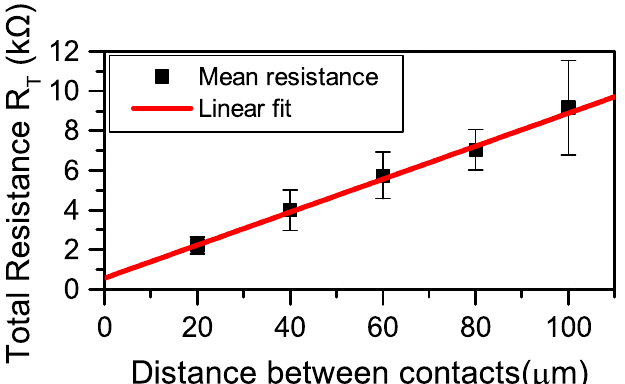
Figure 5. Contact resistance per the TLM method for the fabricated graphene-based devices. The measured resistance as a function of the distance between contacts. Squares represent the mean data points collected from six devices. The red line is the linear fit to the data points and intercepts the y-axis at R T = 2 R c